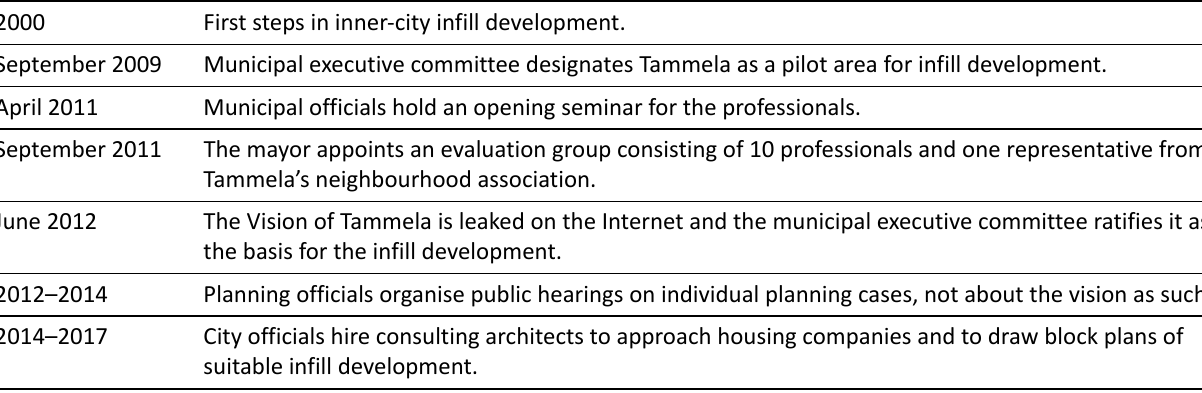
Table 1. Timeline of Tammela’s urban densification